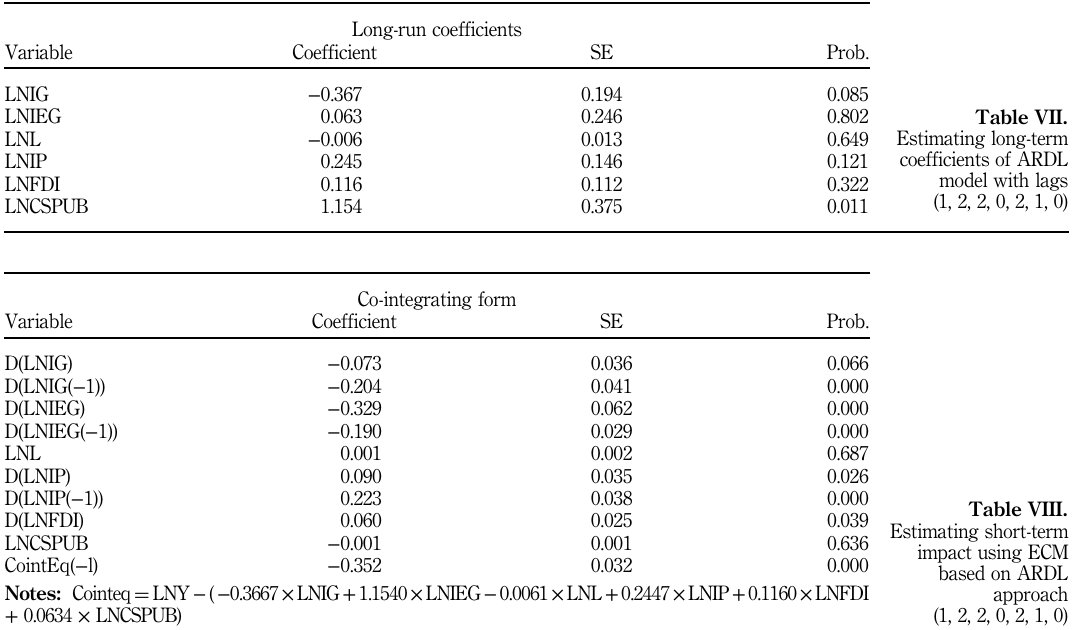
Table VIII. Estimating